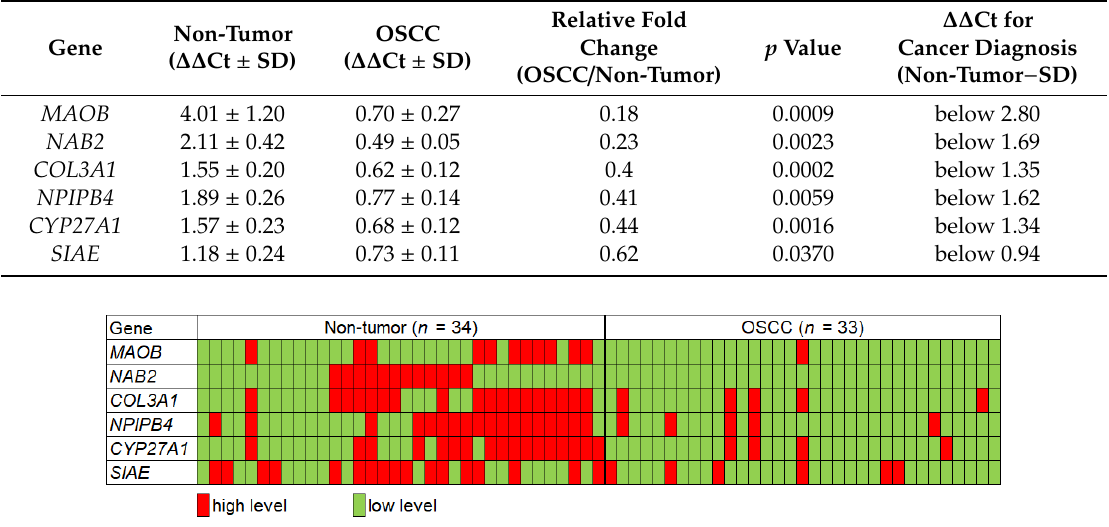
significant di ff erences between OSCC patients and controls. The detailed statistics of the AUCs from ROC curves, sensitivities, and specificities are listed in Table 3. In the univariate ROC analysis, SIAE (AUC, 0.70; sensitivity, 0.79; and specificity, 0.50) mRNA performed most favorably for